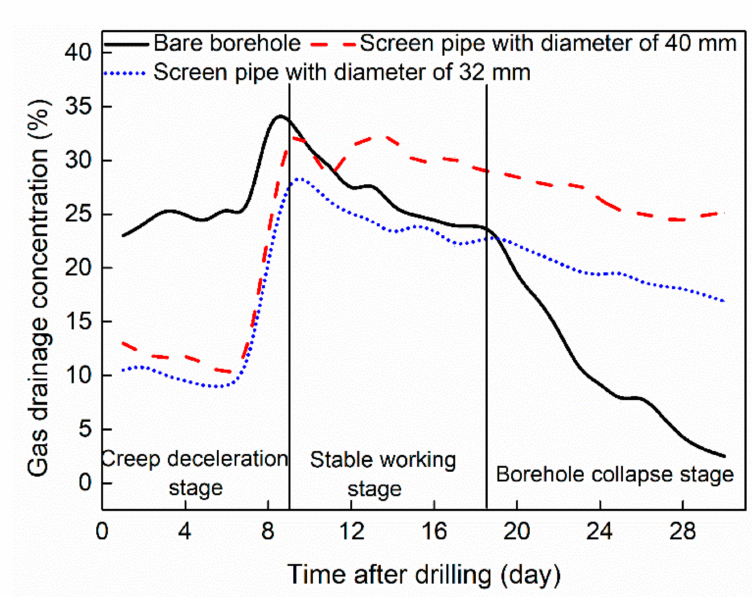
Figure 12. Influence of screen pipe diameter on gas drainage